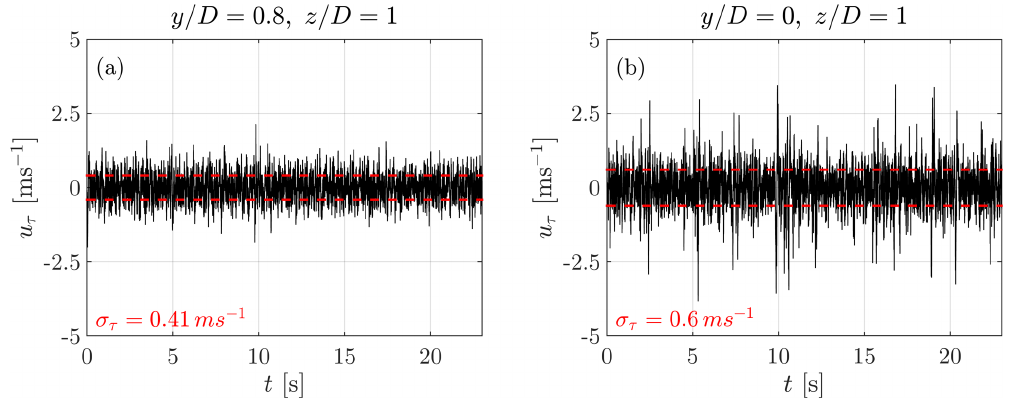
Figure 11. Time series of increments u τ ( t ) for the positions y/D = 0 . 8, z/D = 1 (free stream, a ) and y/D = 0, z/D = 1 (a) . The standard deviations σ τ are indicated in red.